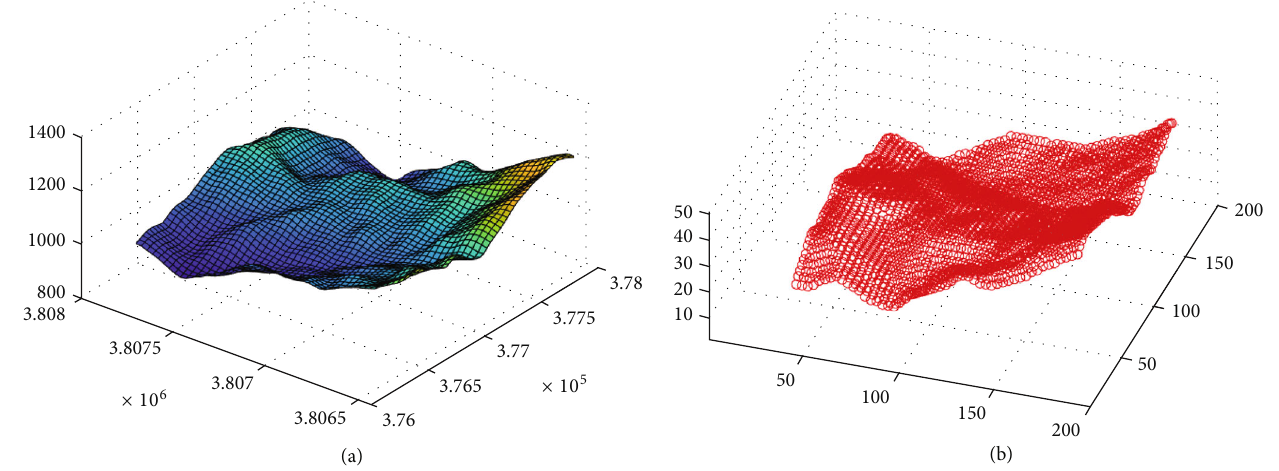
Figure 4: (a) The surface of the topographic map; (b) obstacles represented in the grid